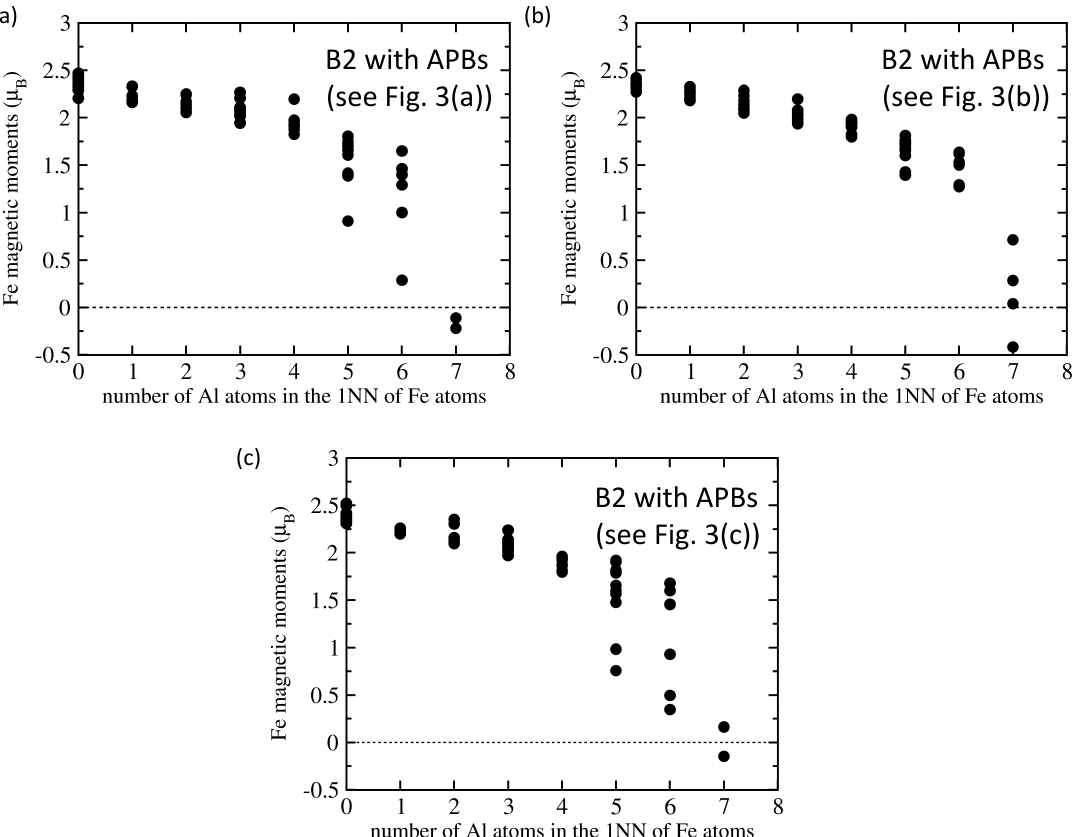
Figure 4. Computed local magnetic moments of Fe atoms in the supercells visualized in Figure 3a–c are summarized in parts ( a – c ), respectively, as a function of the number of Al atoms in the 1NN shell of Fe